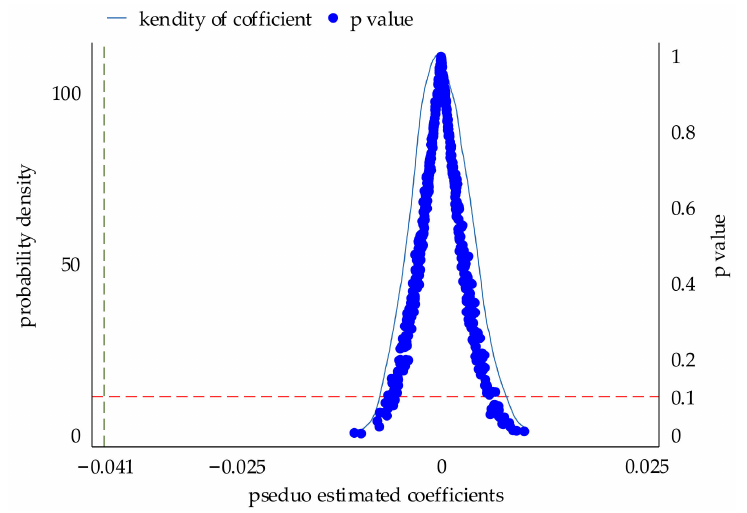
Figure 6. Results of the Placebo